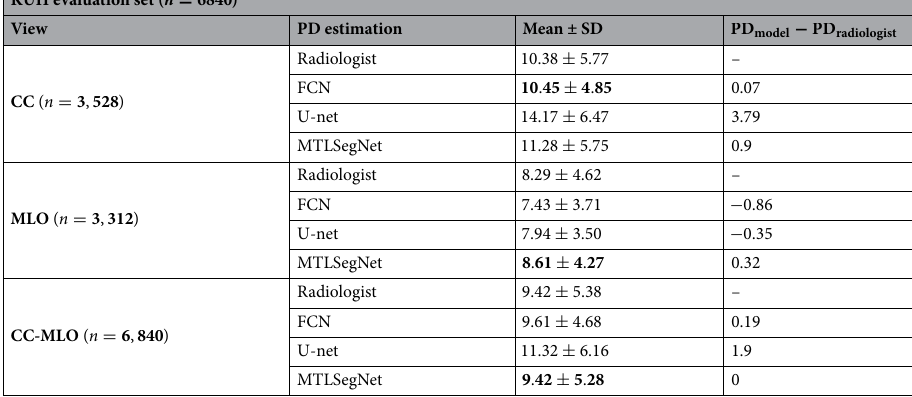
Table 5. Descriptive summary of estimated PD values by the FCN, U-net, and MTLSegNet approaches on the KUH evaluation dataset. We use the mean and the standard deviation (SD) to illustrate the distribution of the PD values and compare the robustness of the model predictions. The number in the brackets denotes the number of mammograms in each view of the KUH evaluation dataset. The last column represents the mean difference between the estimated PD values and the radiologist-provided PD values. We highlighted the model, whose mean difference is close to the reference (radiologist) mean PD value. Lower the mean difference, better the model performance. The negative mean difference indicates that the model has underestimated the PD values compared to the radiologist-provided PD values. Best values are in [bold].